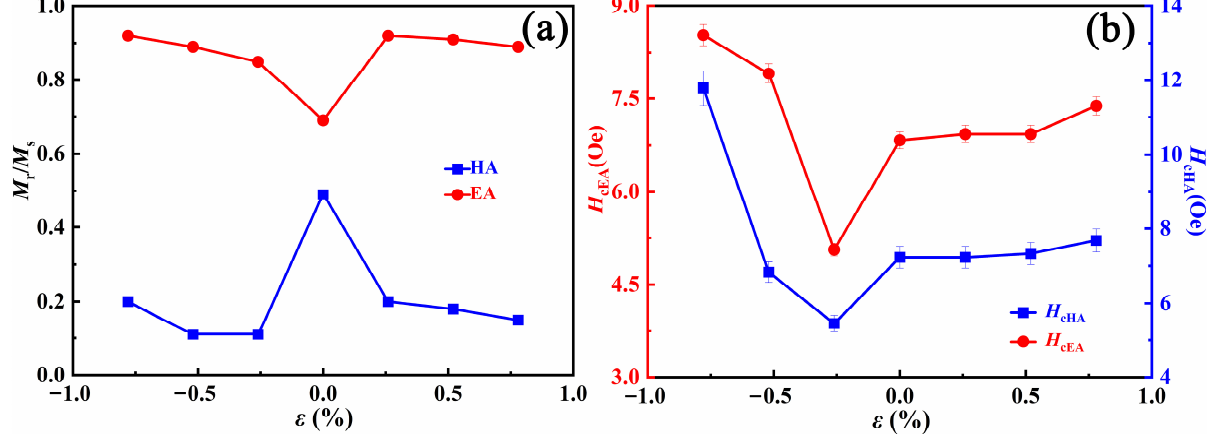
Figure 5. Static magnetic properties of TFNFT multilayer films under various external strains: ( a ) remanence ratio M r / M s in the EA and HA, respectively; ( b ) the coercivity ( H c ).